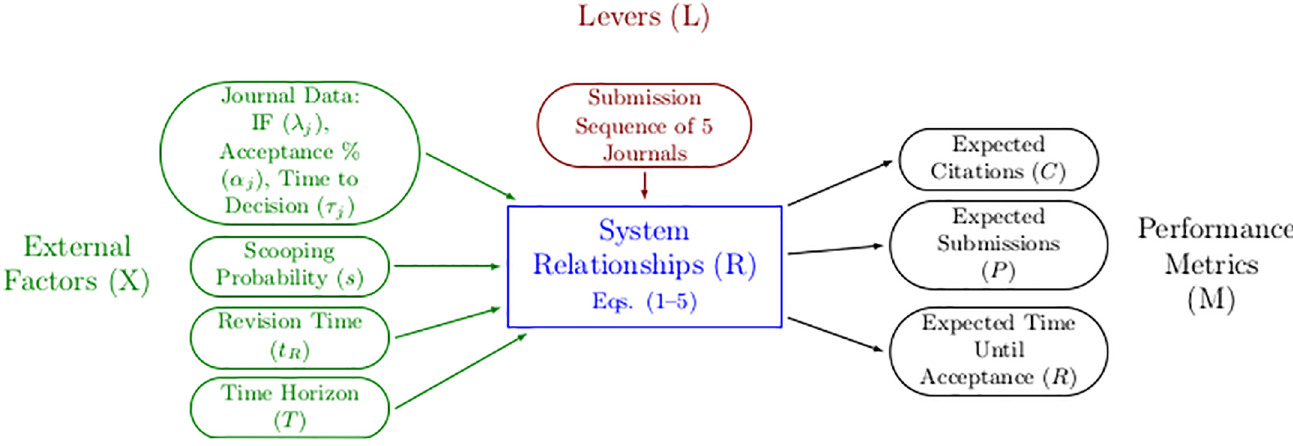
Fig 1. XLRM framework. Illustration of the externalfactors (X), levers the decision-maker can manipulate to affect the outcome (L), the modeling relationships (R) and the performance metrics (M) in the formulationof the journalsubmission decisionproblem [10].